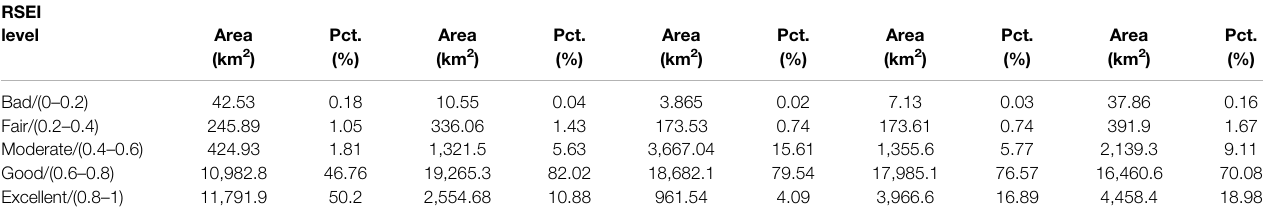
TABLE 4 | Area and percentage changes of each RSEI level in different years. RSEI level